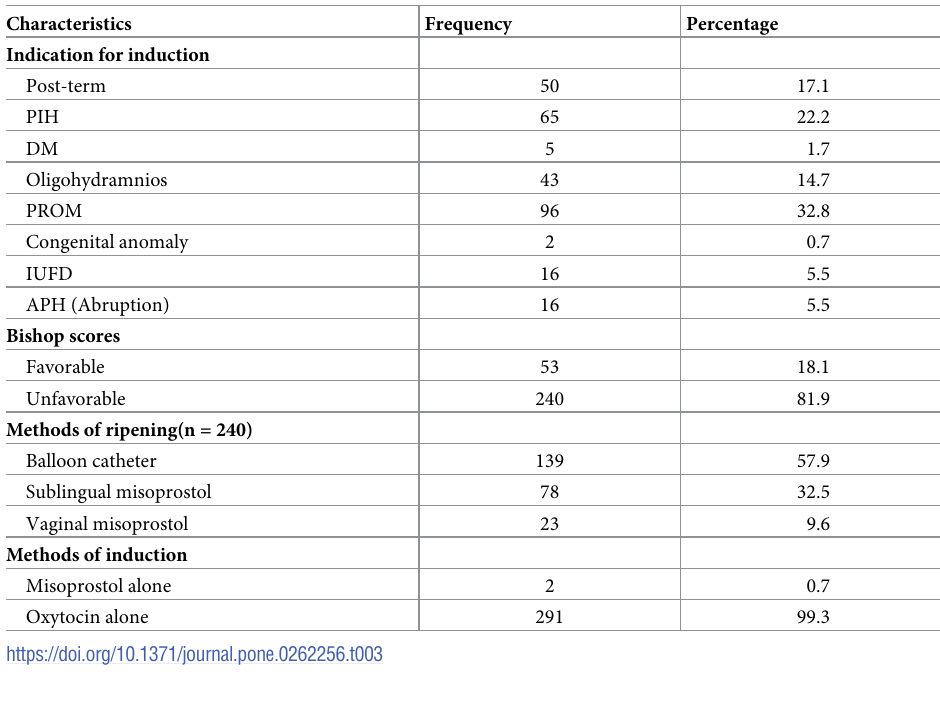
Table 3. Ripening and induction-related characteristics of the study participants, in Adama Hospital Medical College, East Shoa, Ethiopia, 2020 (n = 293).